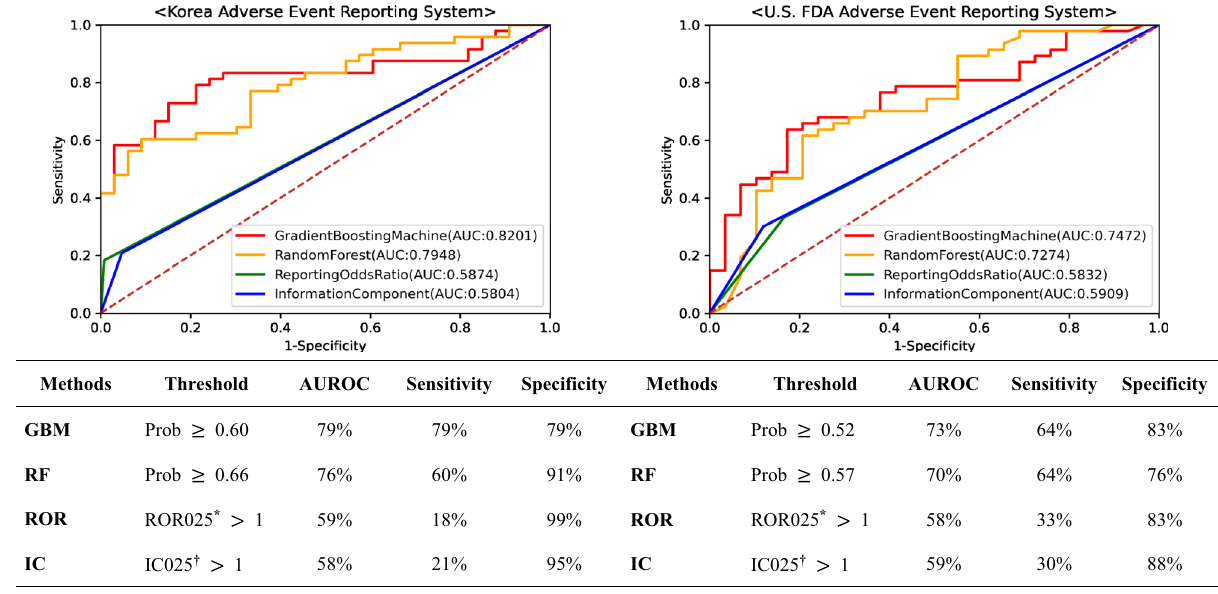
Figure 2. Receiver operating characteristic (ROC) curve illustrating the prediction performances of data mining methods used to detect safety signals of infliximab in KAERS (2009–2018) and FAERS (2014–2018). Abbreviation: KAERS, Korea adverse event reporting system; FAERS, FDA adverse event reporting system; AUROC, area under receiver operating characteristic curve; GBM, gradient boosting machine, RF, random forest; ROR, Reporting odds ratio; IC, Information component, Prob, probability. *ROR025 is the lower limit of a 95% confidence interval for estimated reporting odds ratio. †IC025 is the lower limit of a 95% confidence interval for estimated information